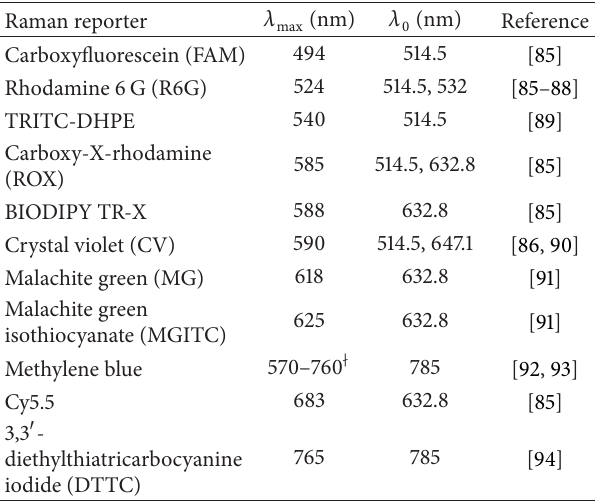
Table 1: A list of molecules used for SERRS enhancement for excitation wavelengths ( 𝜆 0 ) from 514–785 nm and their associated absorption maximums ( 𝜆 max